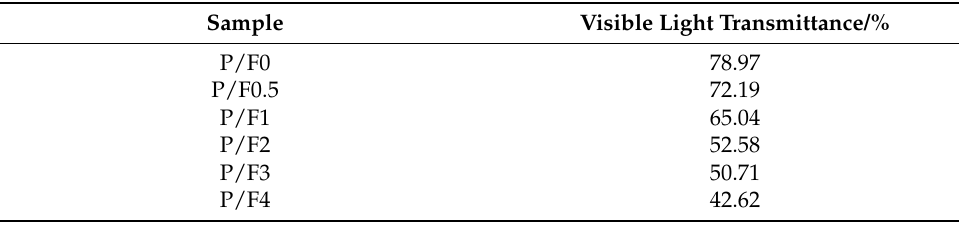
Figure 4. UV-vis transmittance of P/F films. Table 2. Transmittance of P/F films in visible light with different amount of CeF 3